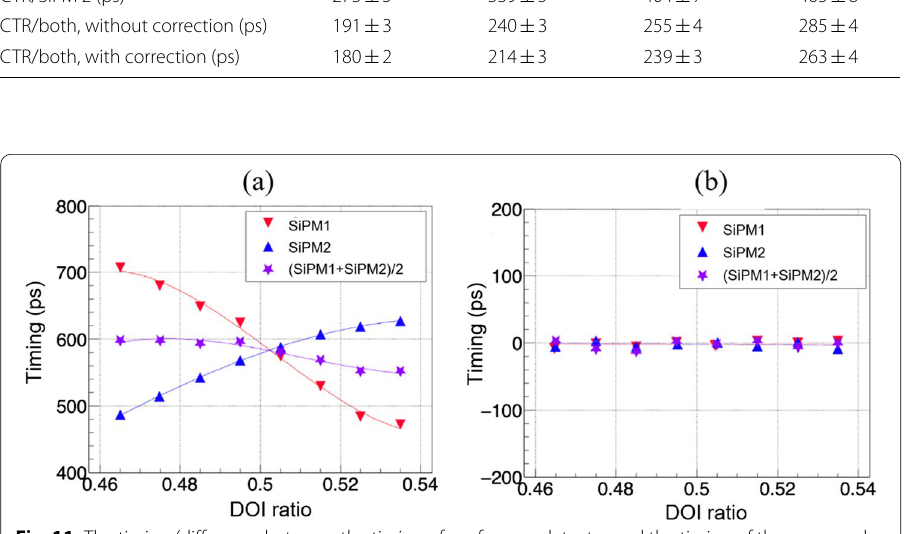
Fig. 11 The timing (difference between the timing of a reference detector and the timing of the measured detector) vs. DOI ratio measured by SiPM 1, SiPM 2 and the average of the two SiPMs for detector 1, a before and b after depth dependence of timing